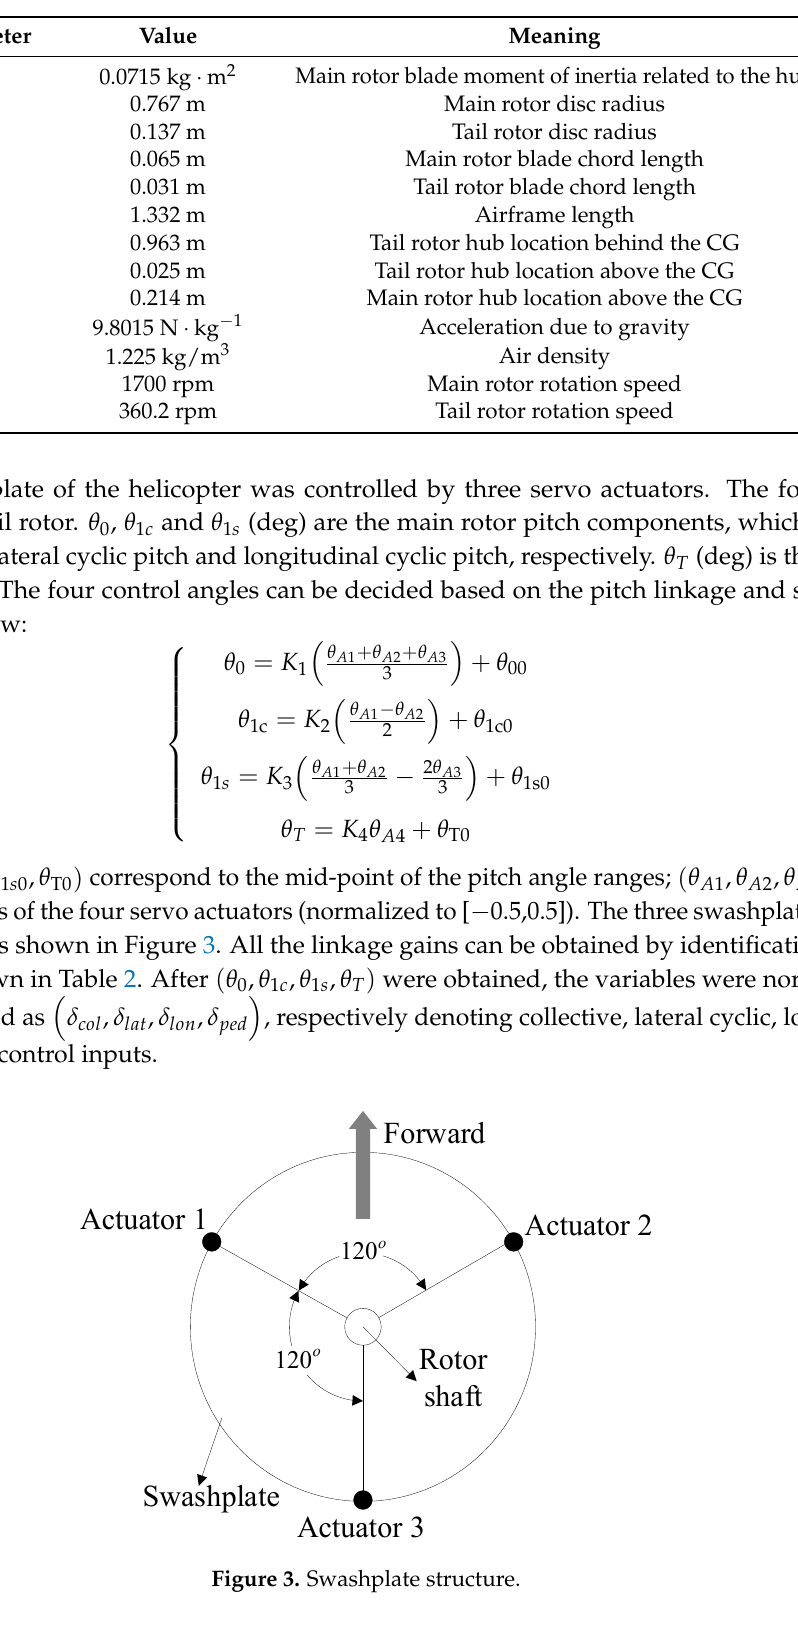
Table 1. Parameters from direct measurement.